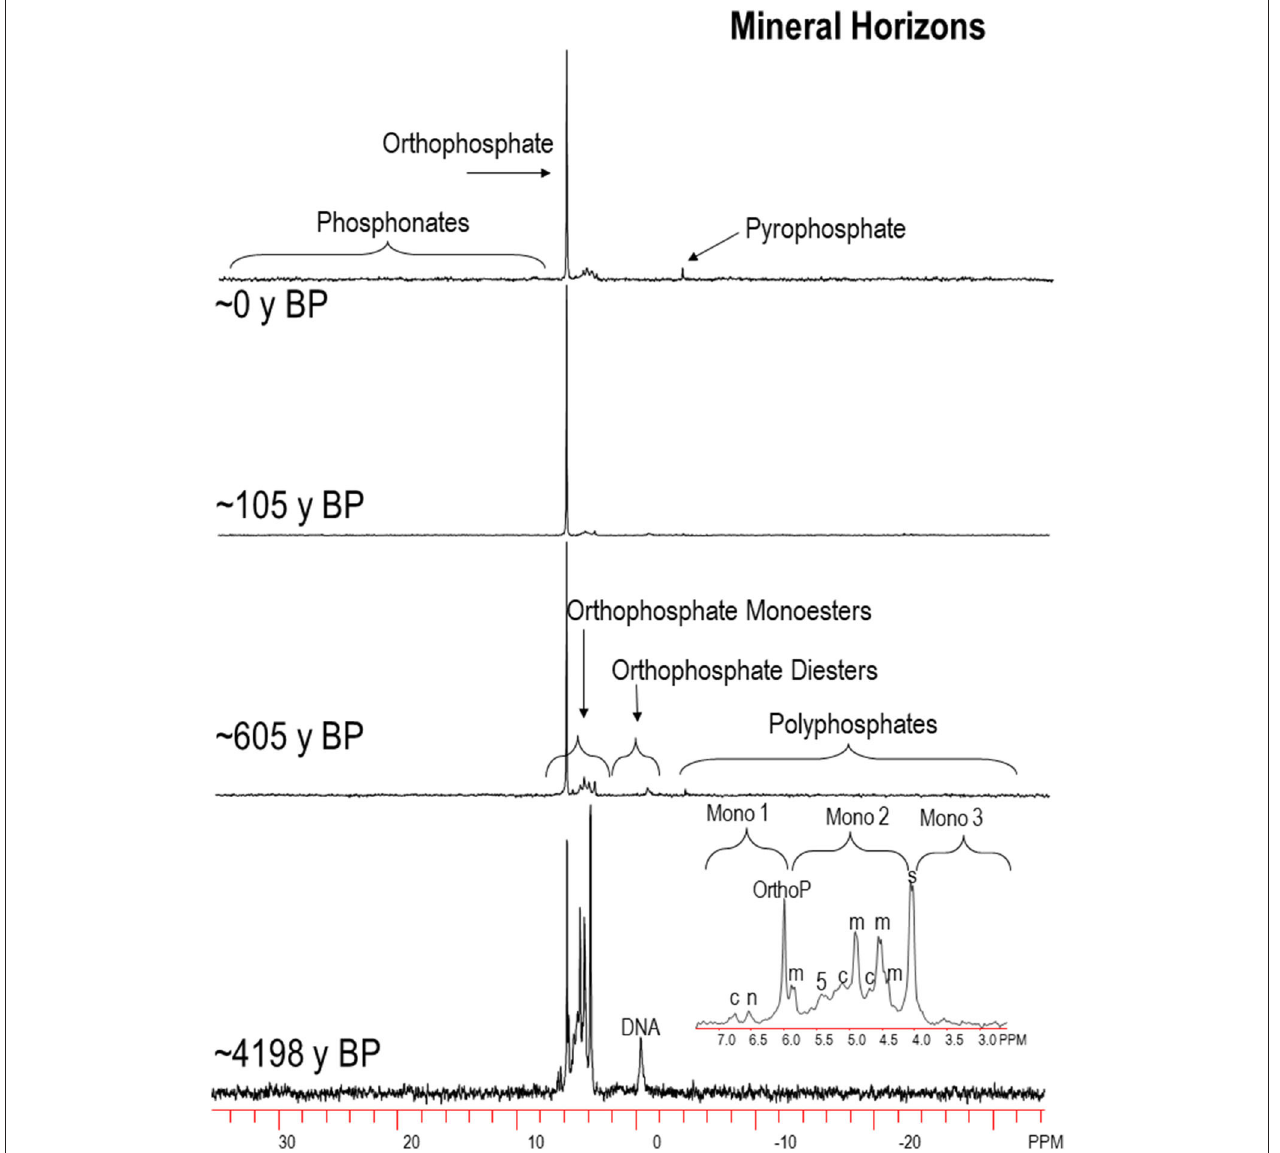
FIGURE 4 | Select 31 P-NMR spectra for humic-enriched mineral (M horizon) samples (A or B horizon depending on age) along the Calvert Island chronosequence extracted with NaOH-EDTA and processed with 7Hz line-broadening. OrthoP, orthophosphate, Mono, orthophosphate monoesters; α , α -glycerophosphate; β , β -glycerophosphate; AMP, amino monophosphate; 5, unknown peak, 5 ppm; y BP, years before present; c, chiro -inositol hexaphosphate (IHP); m, myo -IHP; n, neo -IHP; s, scyllo -IHP; See text for more